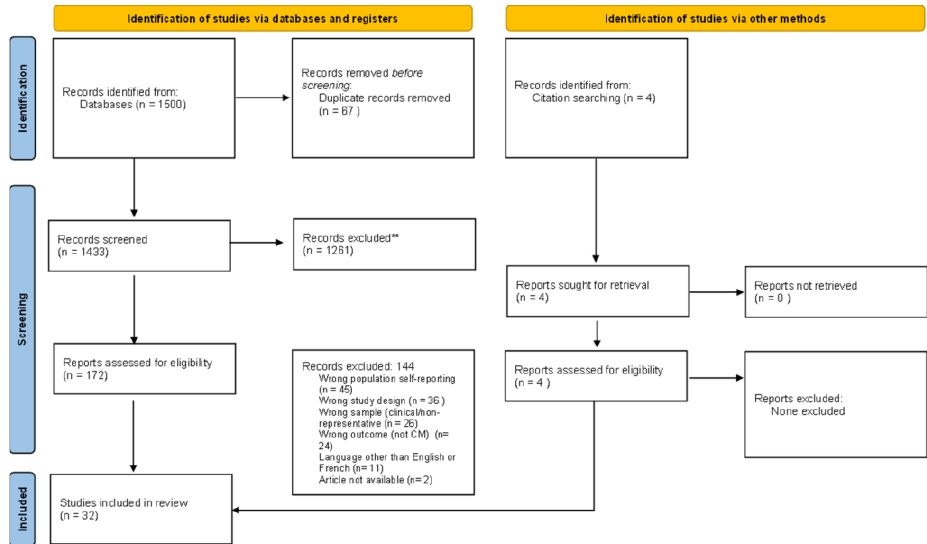
Figure 1. PRISMA Flow Chart. ** All records were screened by A.S.T. and I.G.D., no automation tools were used to exclude